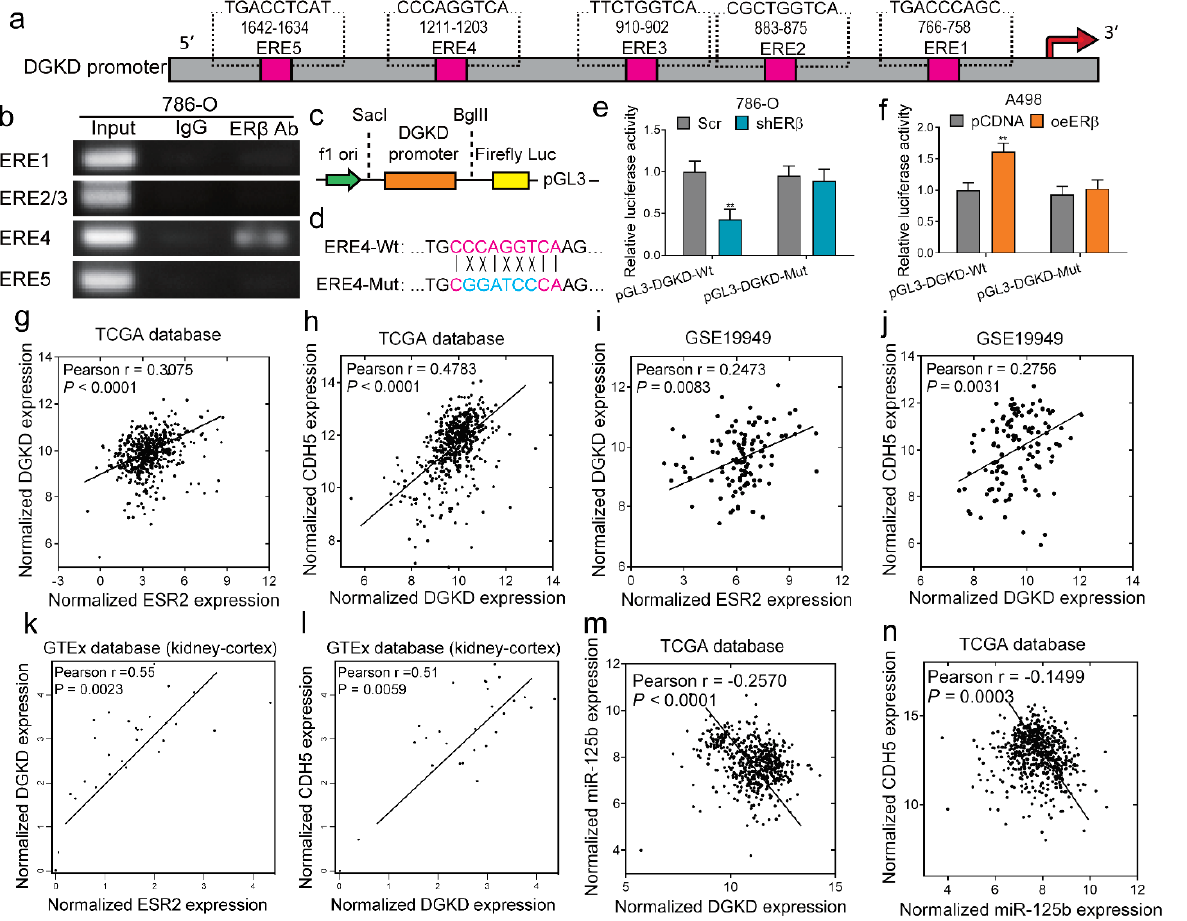
Figure 5. Mechanism dissection showed ER β binds to the promoter of DGKD and transcriptionally up-regulates DGKD mRNA and circDGKD expression. ( a ) Bioinformatic prediction identified 5 putative ER β binding sites within 2 kb promoter of DGKD. ( b ) ChIP assay using DNA agarose gel electrophoresis of PCR products revealed ERE4 was the potential binding site. ( c ) Diagram of cloning the 2 kb DGKD promoter into pGL3-basic luciferase reporter vector (pGL3-Wt) between Sac1 and BglII. ( d ) Site-directed mutagenesis of ERE4 by mutating part of the ERE into BamHI cutting site (-GGTACC-). ( e , f ) Luciferase assays using wild-type (Wt) or mutant (Mut) pGL3 constructs. In 786-O cells, the shER β decreased the wild-type luciferase activity significantly, but not the mutant ( e ), and in A498 cells, overexpression of ER β increased the Wt luciferase activity significantly, but not the Mut ( f ). ( g – n ) Public database analysis of relevant correlations. TCGA ccRCC data analysis revealed a positive correlation between the expression level of ER β (ESR2) and DGKD ( g ), and between DGKD and VE-cadherin ( h ). GEO datasets (GSE19949 from Mayo Clinic) showed a positive correlation between ER β (ESR2) and DGKD ( i ), and between DGKD and VE-cadherin in ccRCC patients ( j ). GTEx database showed a positive correlation between ER β (ESR2) and DGKD ( k ), and between DGKD and VE-cadherin (CDH5) ( l ) in non-malignant kidney tissues. TCGA ccRCC data analysis showed a negative correlation between the expression level of DKGD and miR-125b ( m ), and between miR-125b and VE-cadherin ( n ). Data are presented as mean ± SEM. ** p < 0.01. RNA-Seq data were retrieved from the TCGA database using the UCSC Cancer Genome Browser (https://genome-cancer.soe.ucsc.edu/, accessed on 8 October 2021) and analyzed as we reported before [29]. The results revealed a positive